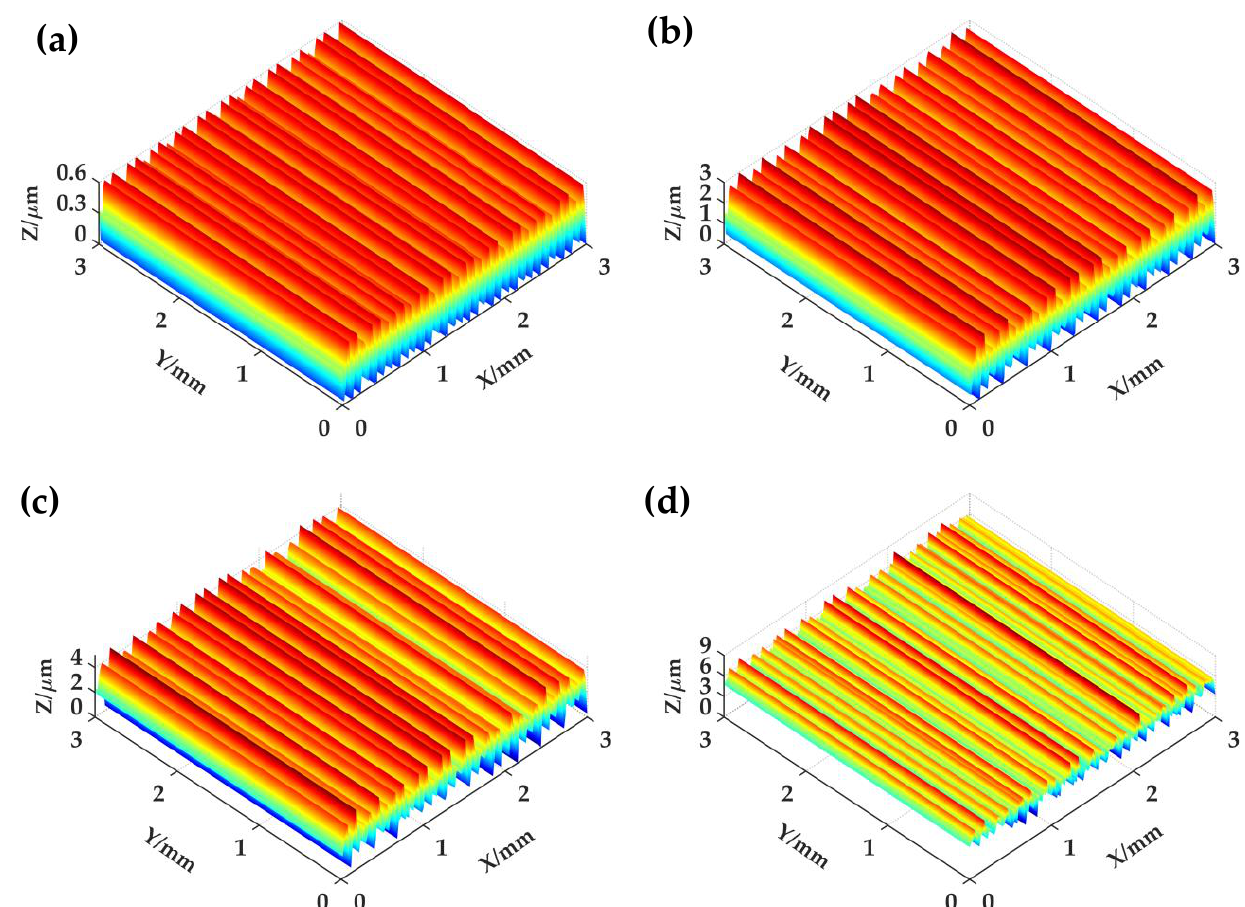
Figure 6. Ubiquitiformal surfaces: ( a ) Surface 1; ( b ) Surface 2; ( c ) Surface 3; ( d ) Surface 4.